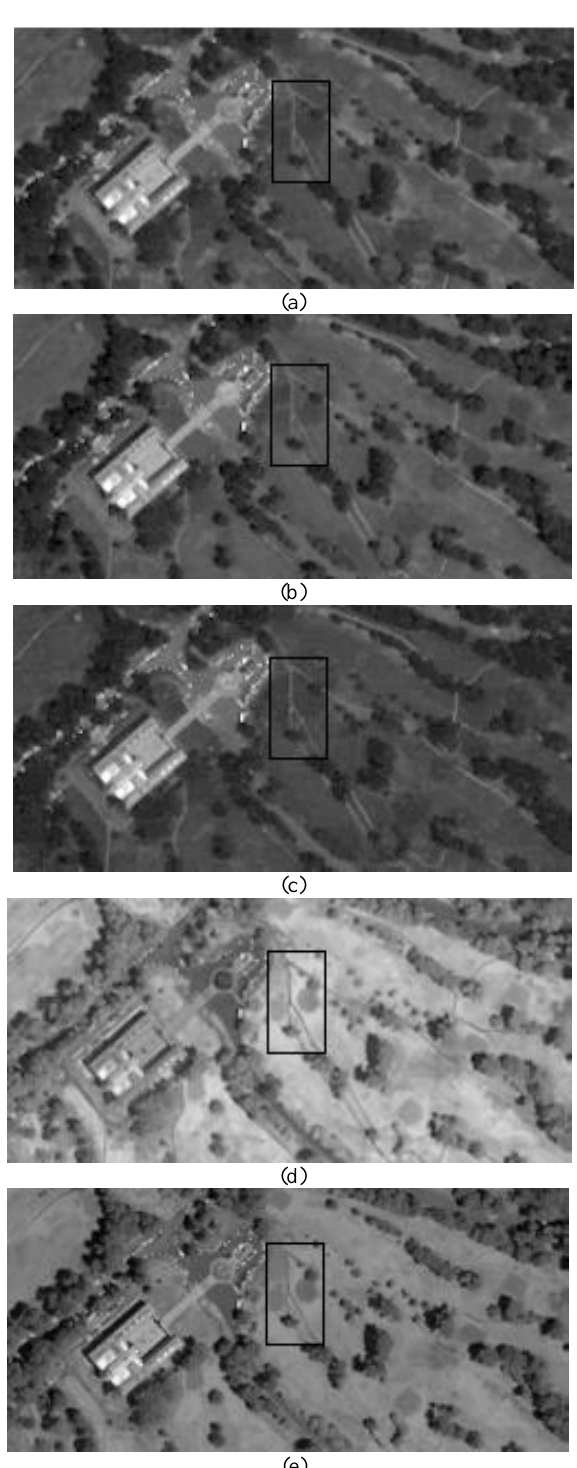
Figure 2. Illustration of contrast inversion or contrast reversal information in satellite imageries (a) Red band. (b) Green band (c) Blue band (d) NIR band. (e) PAN band down-sampled to spatial resolution of